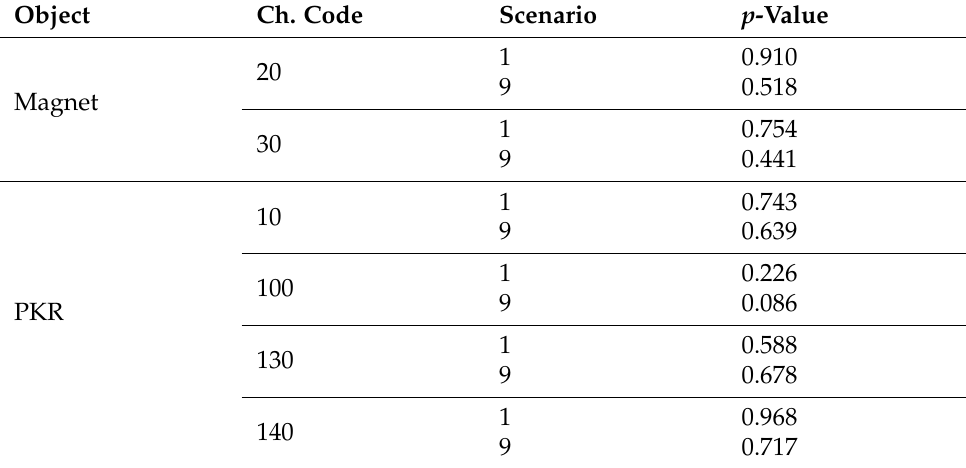
Table 3. Calculated p-values of normality test using Anderson Darling normality test. Values are calculated for all measured characteristic codes for one repetition of scenario 1 and scenario